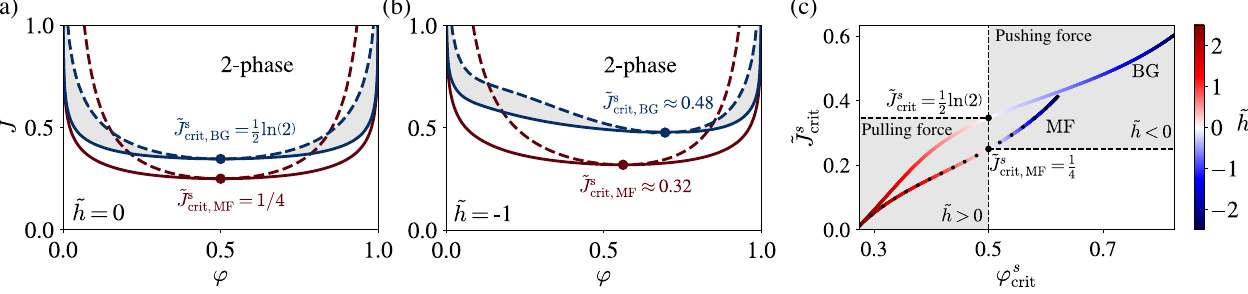
FIG. 12. Comparison of the BG and MF binodal line, spinodal line, and statical critical point. (a,b) Phase diagram for (a) zero force ˜ h ¼ − 1 . The solid and dashed lines depict the binodal and spinodal lines, respectively. Red lines correspond to the and (b) pushing force mean field approximation obtained with Eqs. (C3) (for zero force) and (C4). Blue lines correspond to the Bethe-Guggenheim approximation in Eqs. (15) (for zero force) and (16). The shaded area depicts the region where the system is metastable for the Bethe- Guggenheim approximation. The blue and red circles depict the statical critical point ð φ s Guggenheim approximations, respectively. (c) Statical critical point as a function of the force is the result obtained with a converged Newton ’ s series [see Eq. (D17)], whereas the mean field result is obtained by considering the first ten terms of Eq.